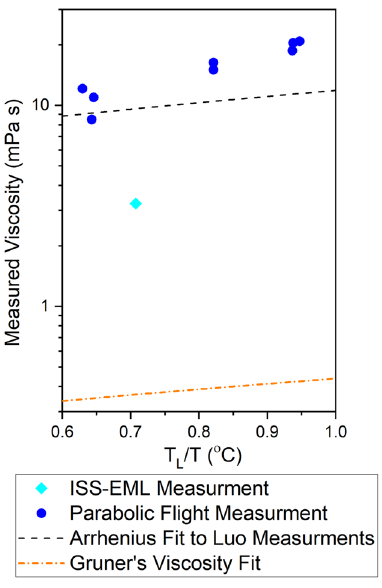
Fig. 1 Viscosities measured during parabolic fl ight testing across a range of different temperatures and compositions of Ge-Si adapted from ref. 2 . In light blue, the measurement taken in the ISS- EML is plotted 3,7 . The result from the ISS-EML is about an order of magnitude lower than the results of the parabolic fl ight experi- ments. However, ground-based techniques are still an order of magnitude lower 8